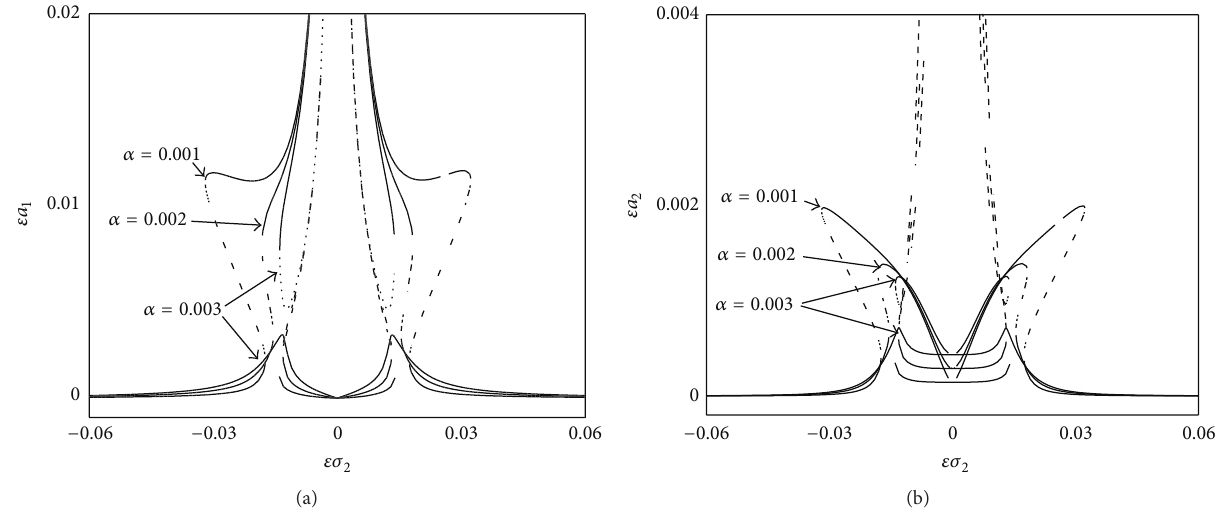
Figure 14: Amplitude-frequency curves of the difference resonance for different viscosity coefficients: (a) the first mode and (b) the second mode.